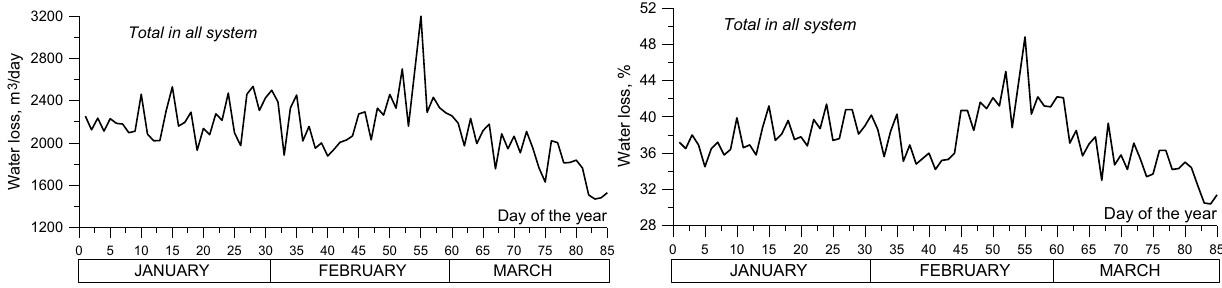
Fig. 4 Volume of water lost in the entire water supply system in 2020 in m 3 (left) in % of water production (right)